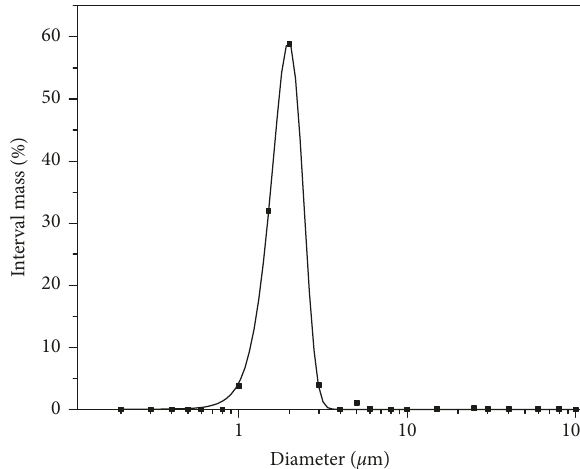
Figure 1: Particle size distribution of the CaO-ZnO catalyst.